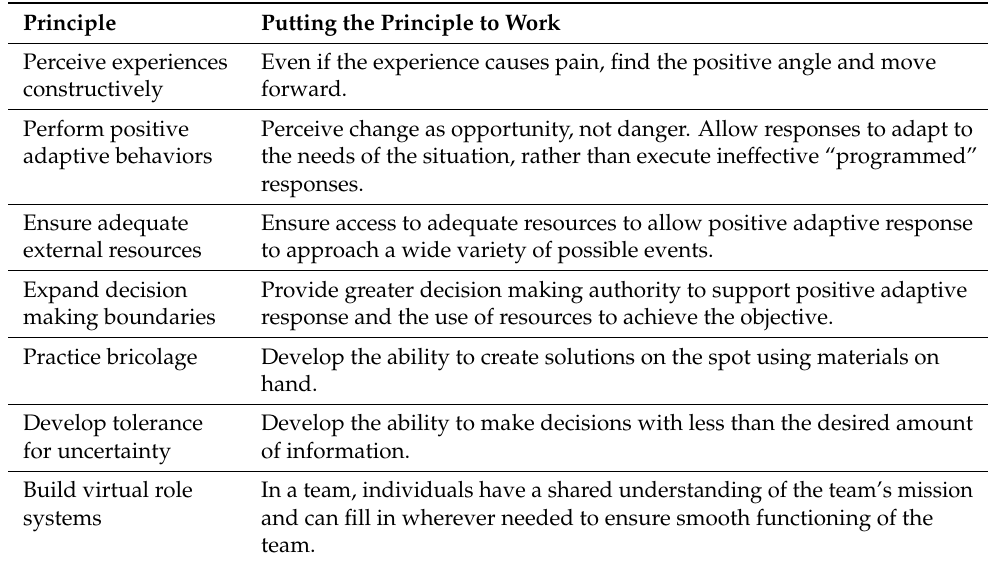
Table 1. Summary of resilience